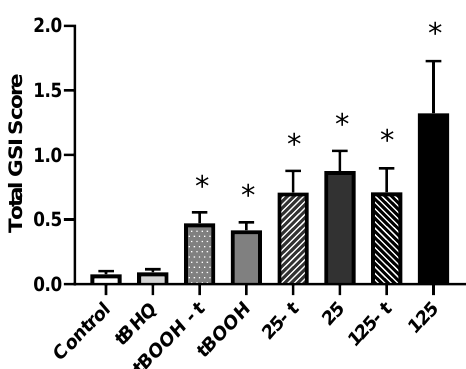
Figure 7. Mean ( ± SE) graduated severity index (GSI) scores for total deformities (sum of skeletal, craniofacial, finfold, and edema scores) in larval zebrafish exposed via embryo aqueous exposure to facility water (control), tBHQ, tBOOH, and two concentrations of SeMet (25 and 125 µ g Se / L) either with (tBOOH-t, 25-t, 125-t) or without (tBOOH, 25, 125) a tBHQ pre-treatment. Asterisks represent significant di ff erences from control using a Kruskal–Wallis one-way analysis of variance (ANOVA) by ranks followed by a Dunn’s multiple comparisons test ( p < 0.05); n = 13–33 replicates of 20 embryos. The severity of kyphosis increased significantly in the 25 µ g / L group as well as both 125 µ g / L treatment groups ( p ≤ 0.037), with severity / GSI scores of 0.0991 ± 0.035, 0.142 ± 0.053, and 0.340 ± 0.13 in the 25, 125-t, and 125 treatments, respectively, compared to 0.0048 ± 0.003 in the controls. The